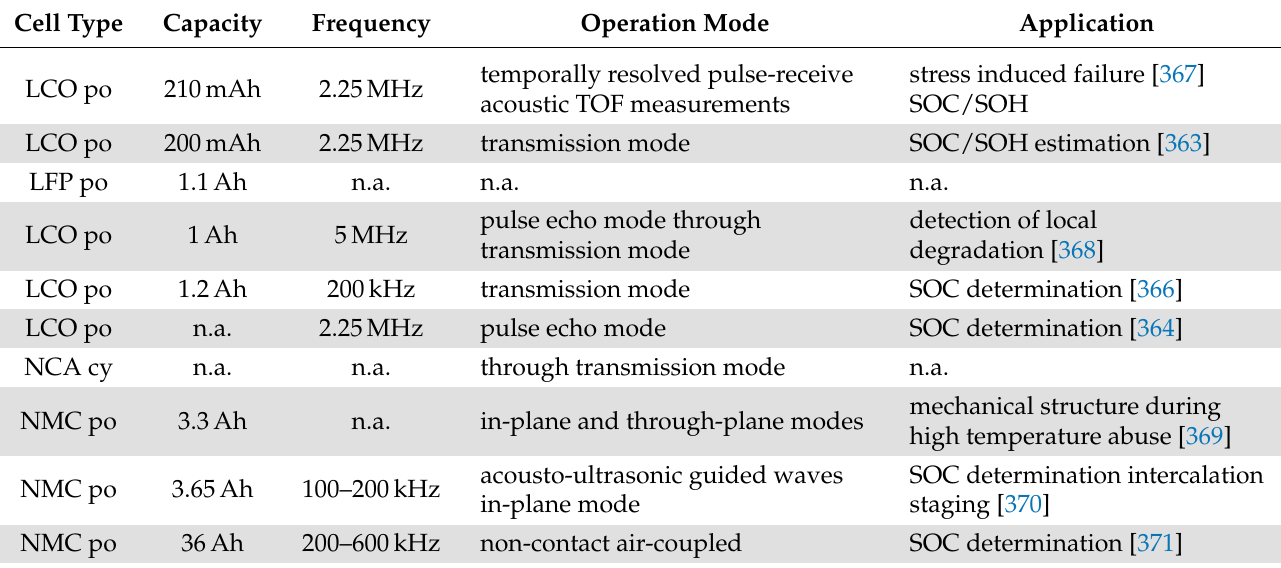
Table 6. Application of ultrasonic probing for characterization of Li-ion cells in the literature. All cells feature graphite anodes. Abbreviations: pouch (po), cylindrical